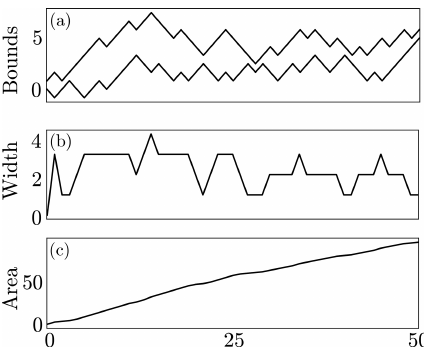
Figure 3. Diagrams showing (a) the positions of two random walks that define the boundary of a watershed, (b) the random walk of w ( s ), and (c) its integral A ( l ).